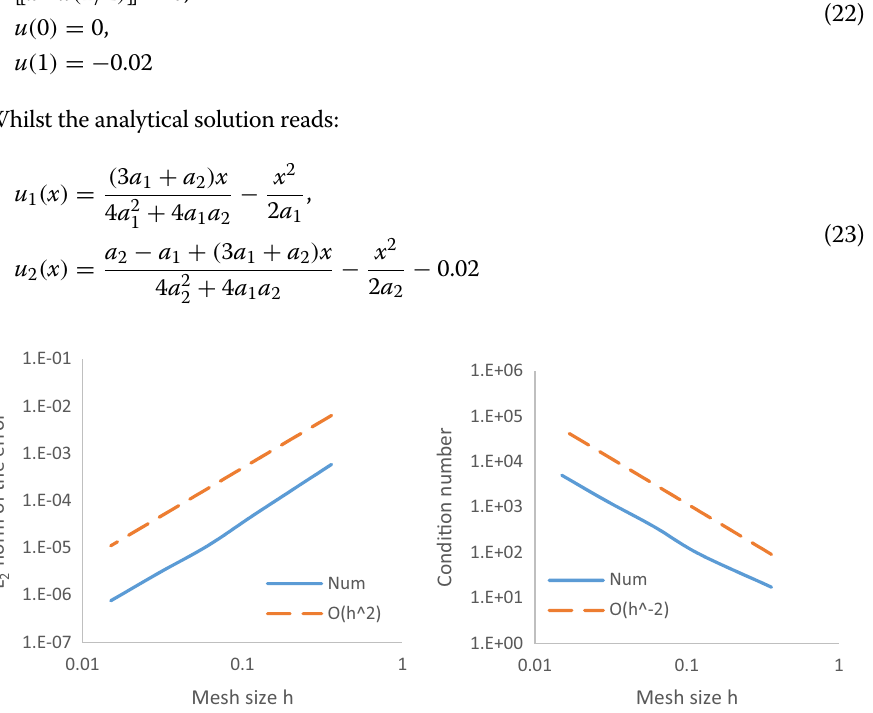
Fig. 15 Plot of the L 2 -norm of the error and 2-norm condition number